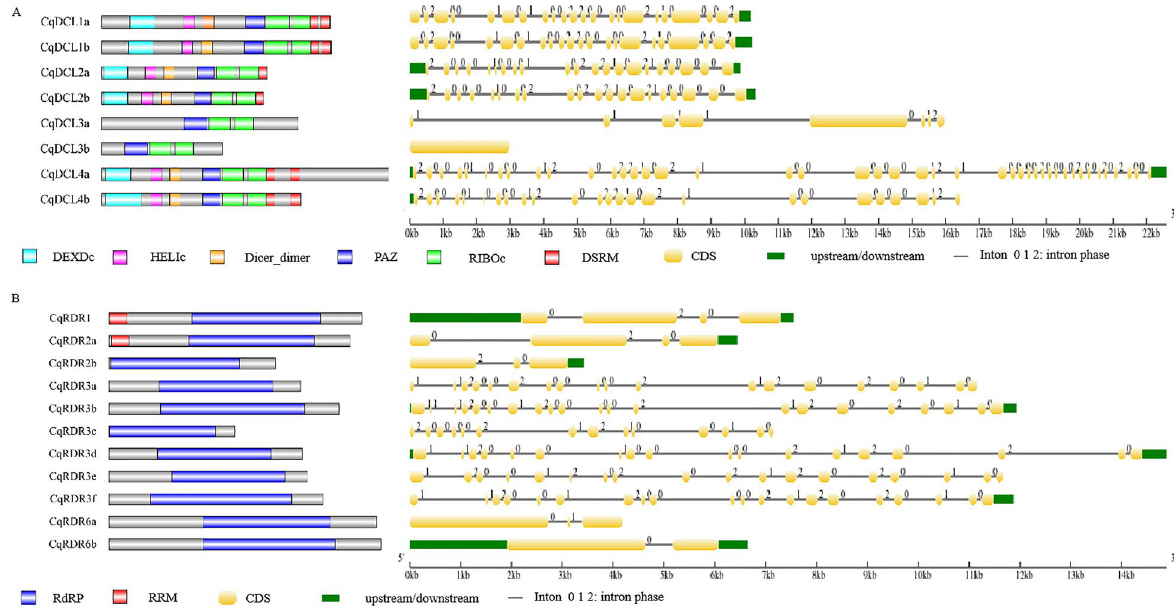
Figure 3. Domain structure of CqDCLs and CqRDRs (left). ( A ) Conserved domains of CqDCL proteins identified by SMART and Pfam, and generated using IBS. The protein domains include DEXDc, HELICc, Dicer- dimer, PAZ, RIBOc, and DSRM. ( B ) Conserved domains of CqRDR proteins identified by SMART and Pfam, and generated by IBS. The protein domains include RRM and RdRP. Introns in CqDCL and CqRDR genes are shown on the